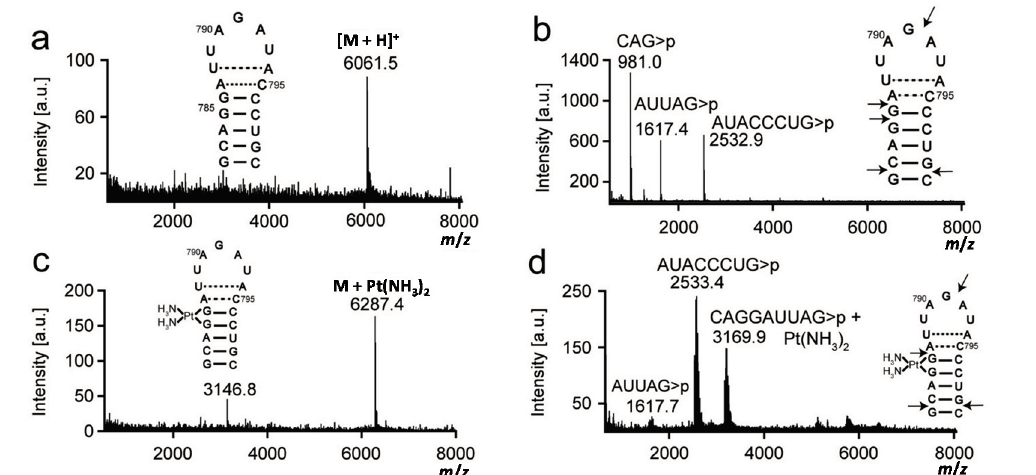
Figure 4. Mass analysis of platinated 790 loop is shown. Mass spectra of ( a ) 790 loop parent strand (unplatinated 790 loop); ( b ) RNase T1 digestion of unplatinated 790 loop; ( c ) platinated 790 loop; and ( d ) RNase T1 digestion of platinated 790 loop are shown. Arrows indicate RNase T1 cleavage